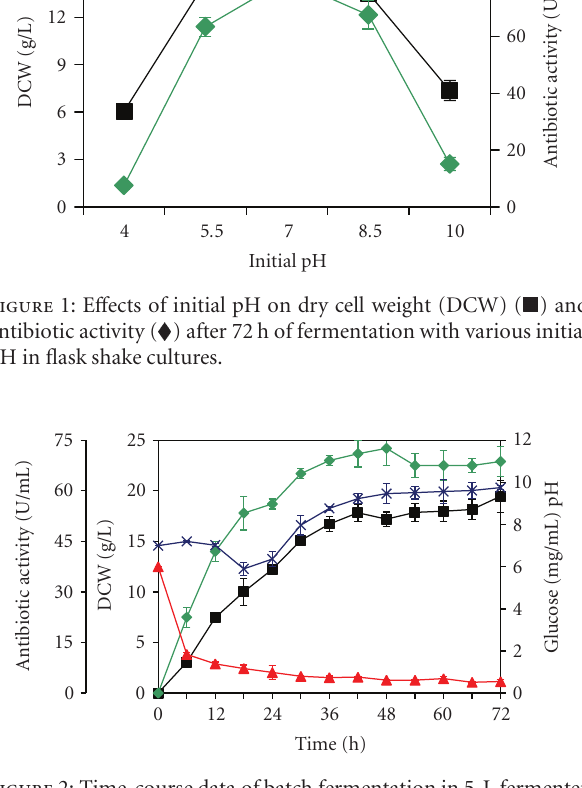
); antibiotic activity (cid:0)